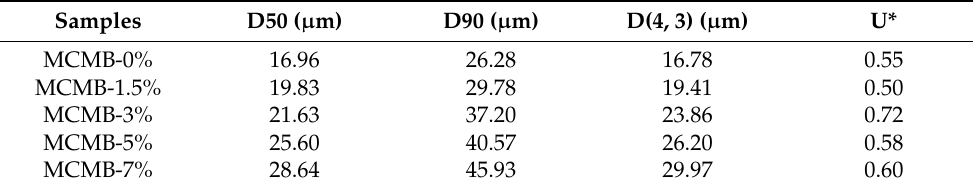
Table 2. The parameters of particle size in MCMBs.